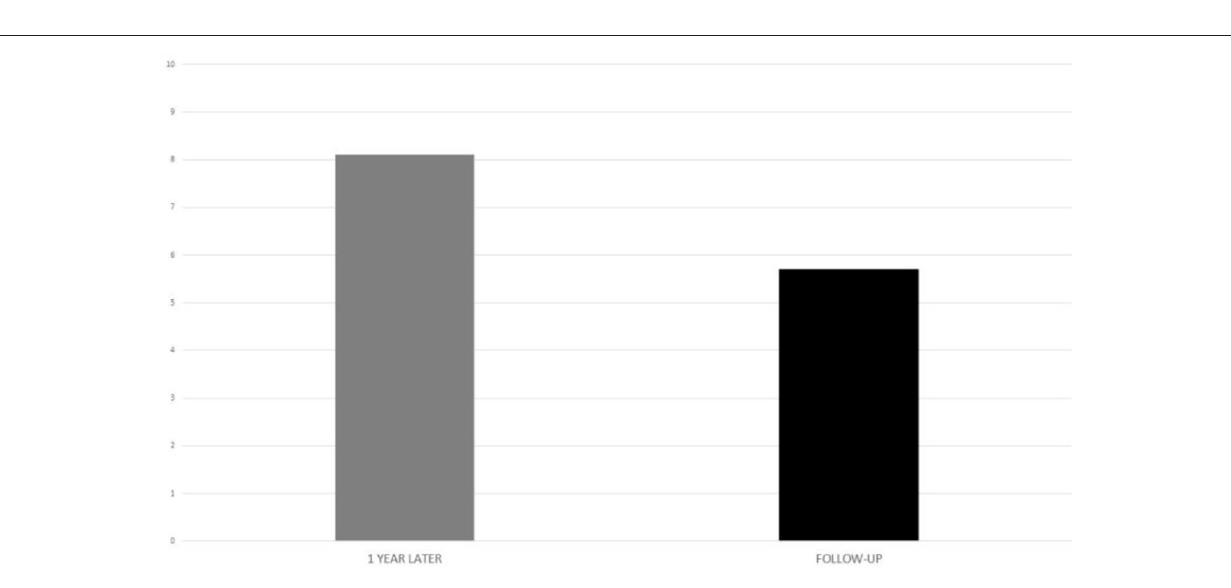
FIGURE 7 | Visual analog scale in the implanted subjects, at activation and